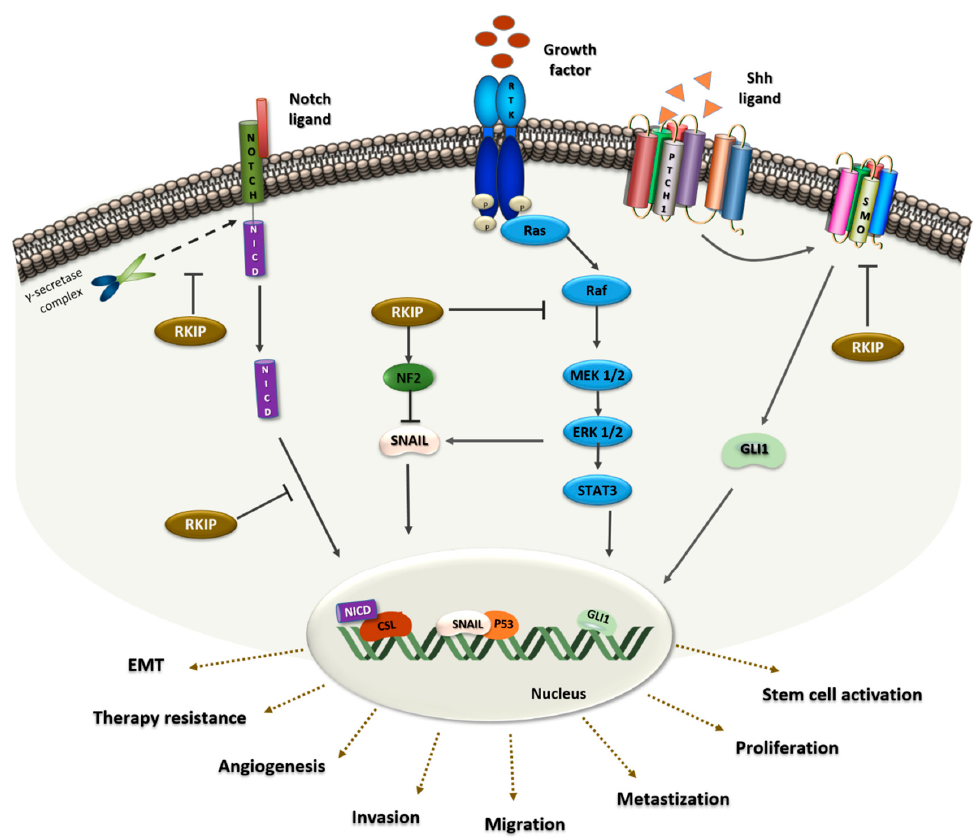
Figure 1. RKIP protein as a signaling modulator in lung cancer. On the left, RKIP binds to the Notch Intracellular Domain (NICD) preventing the proteolytic cleavage by the γ -secretase complex. Furthermore, in the Notch1 pathway, RKIP inhibits the translocation of NICD to the nucleus, which would then activate the translocation of EMT-related genes, ultimately promoting cell invasion and metastasis. In the middle, RKIP binds to Raf, preventing the phosphorylation of MEK by Raf and consequently, Raf / MEK / ERK / STAT3 signaling is inhibited. This will enhance events such as angiogenesis, proliferation and metastization. Additionally, RKIP blocks Snail through MAPK inhibition and NF2 stabilization. In the nucleus, SNAIL acts as a p53 suppressor and upon this EMT related-processes will occur. On the right, RKIP act as an inhibitor of the Shh signaling pathway. RKIP binds to the SMO receptor, keeping it inactive and preventing Gli1 transcription, and promoting therapy resistance and stem cell activation.